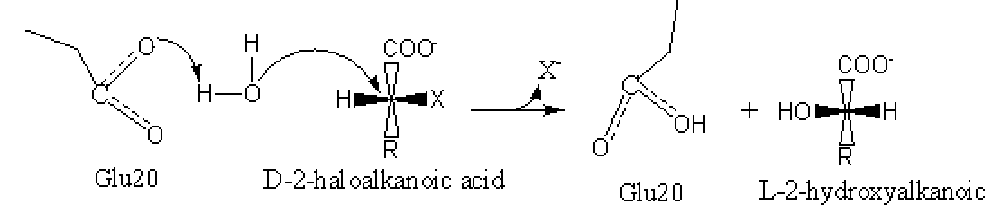
Figure 22. A proposed reaction mechanism for DehD, showing Glu20 activating the water molecule to attack the carbon–halogen bond and displace chloride without the formation of an ester